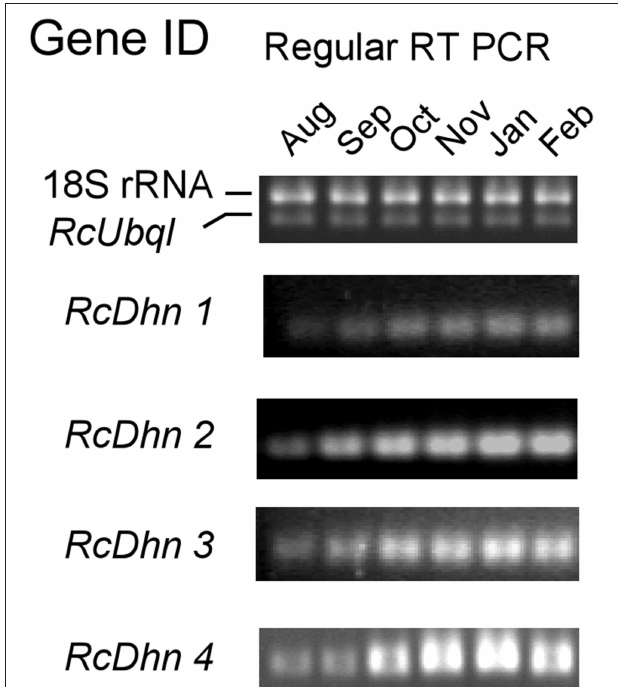
FIGURE 5 | Regular RT-PCR DNA gel images for monthly expression patterns of dehydrin genes in leaf tissues of field-grown R. catawbiense collected in August, September, October, November, January, and February. Total RNA extracted from leaf tissues were used for cDNA synthesis. Regular RT-PCR was conducted by using each dehydrin’s primers, while the Universal 18S Internal Standards primers (Ambion) and gene-specific primers of rhododendron ubiquitin-like ( RcUbql ) gene were used as the mixed primers for the reference genes; the cycle numbers were 32, which was in the exponential phase of the PCR